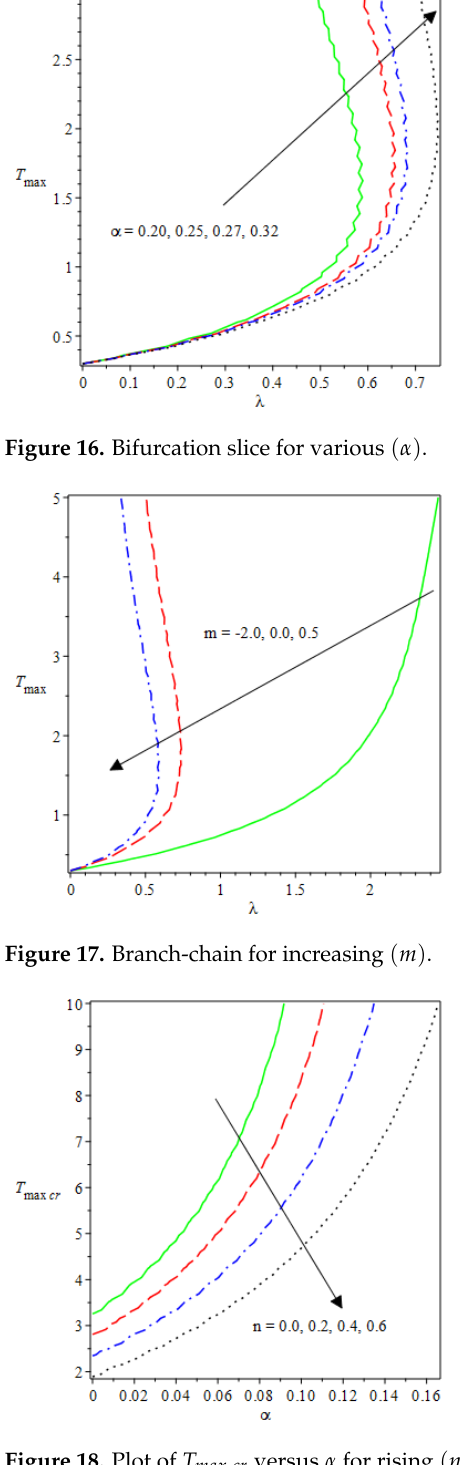
Figure 18. Plot of T max cr versus α for rising ( n )